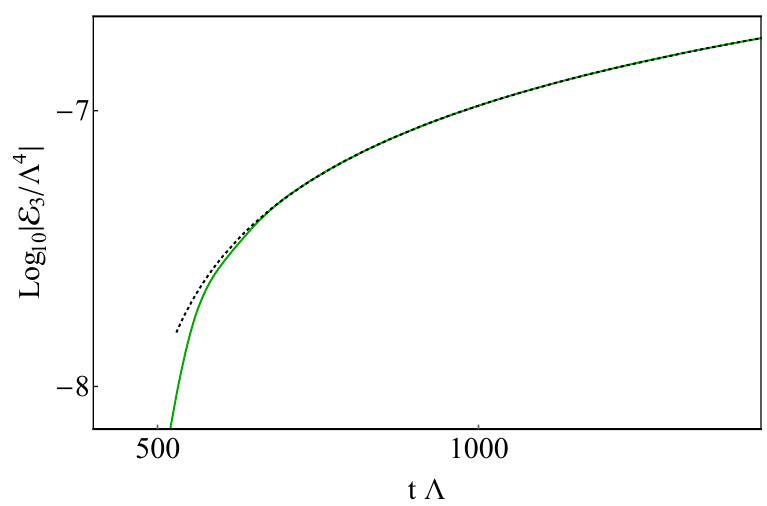
Figure 22 . Fit (3.5) to the time evolution of the n = 3 cosine mode shown in (cid:12)gure 21.